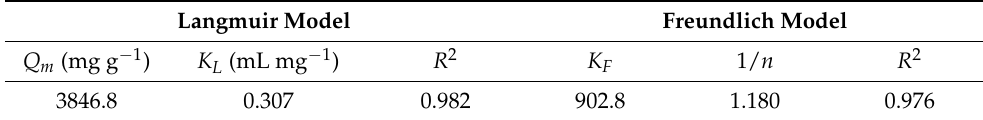
Table 2. The calculated Langmuir and Freundlich constants and correlation